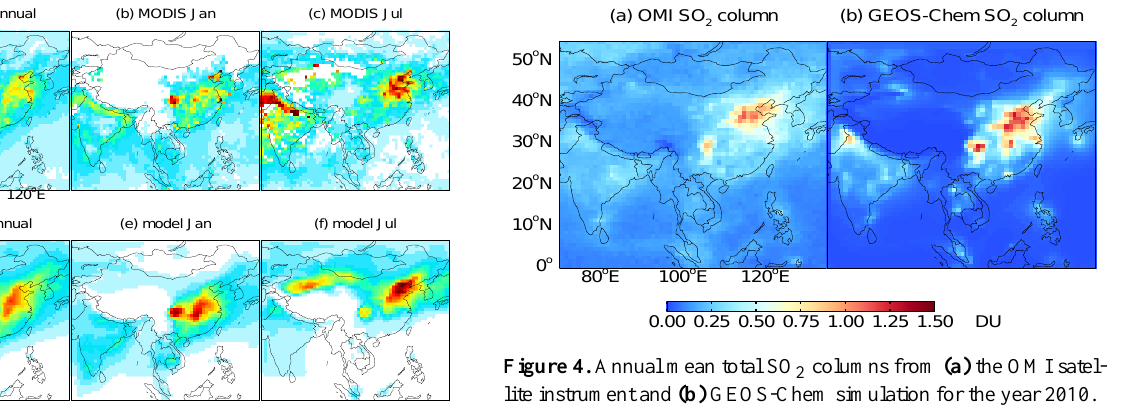
dard simulation is carried out for the period from January